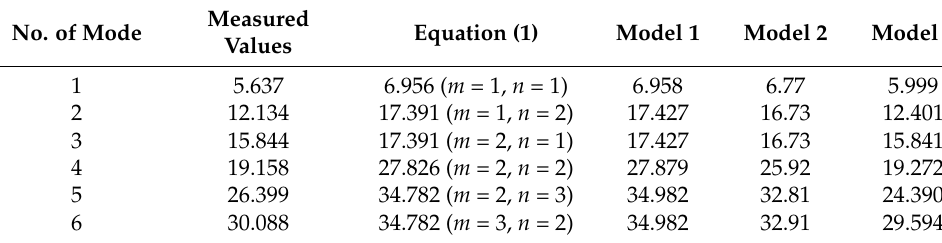
Table 3. Calculation results of natural frequency of sample A.